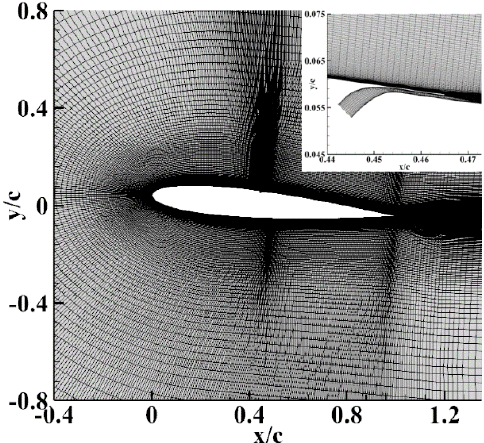
Figure 5. Grid of a tangential blowing slot.